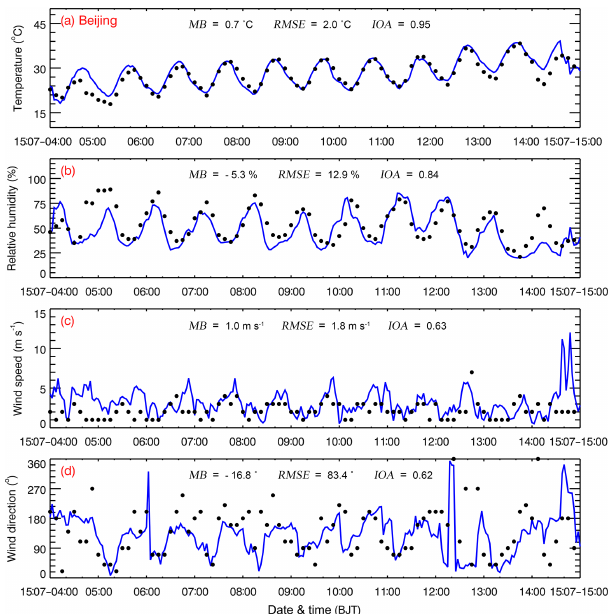
Figure 2. Temporal variations of the simulated (blue line) and ob- served (black dots) near-surface (a) temperature, (b) relative humid- ity, (c) wind speed, and (d) wind direction at the weather station in Beijing from 4 to 15 July